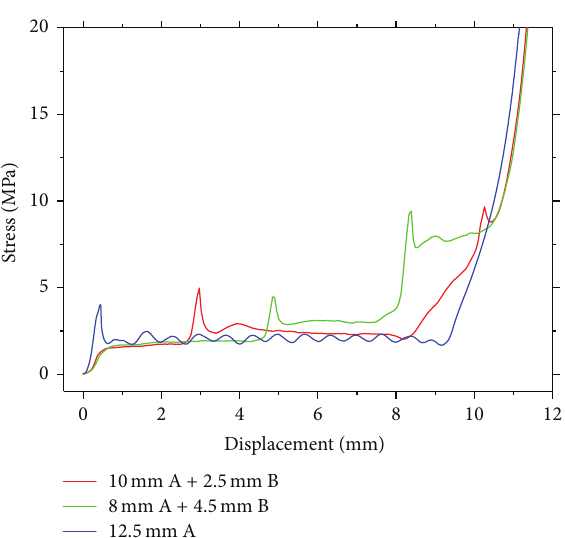
Figure 6: Samples after impact tests.